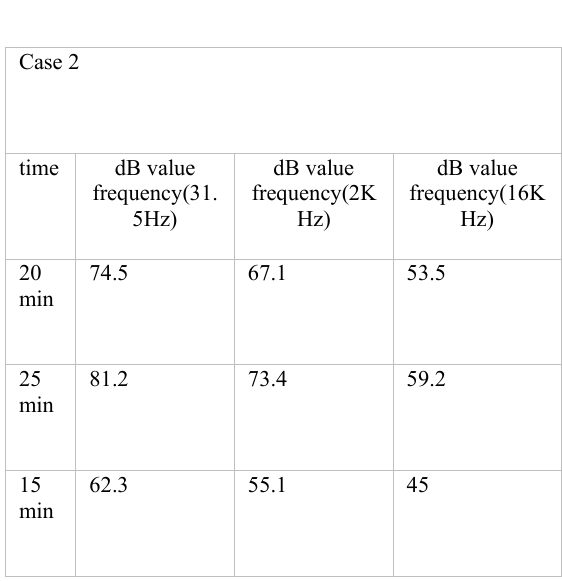
Table 3: Case 2 data for L calculation